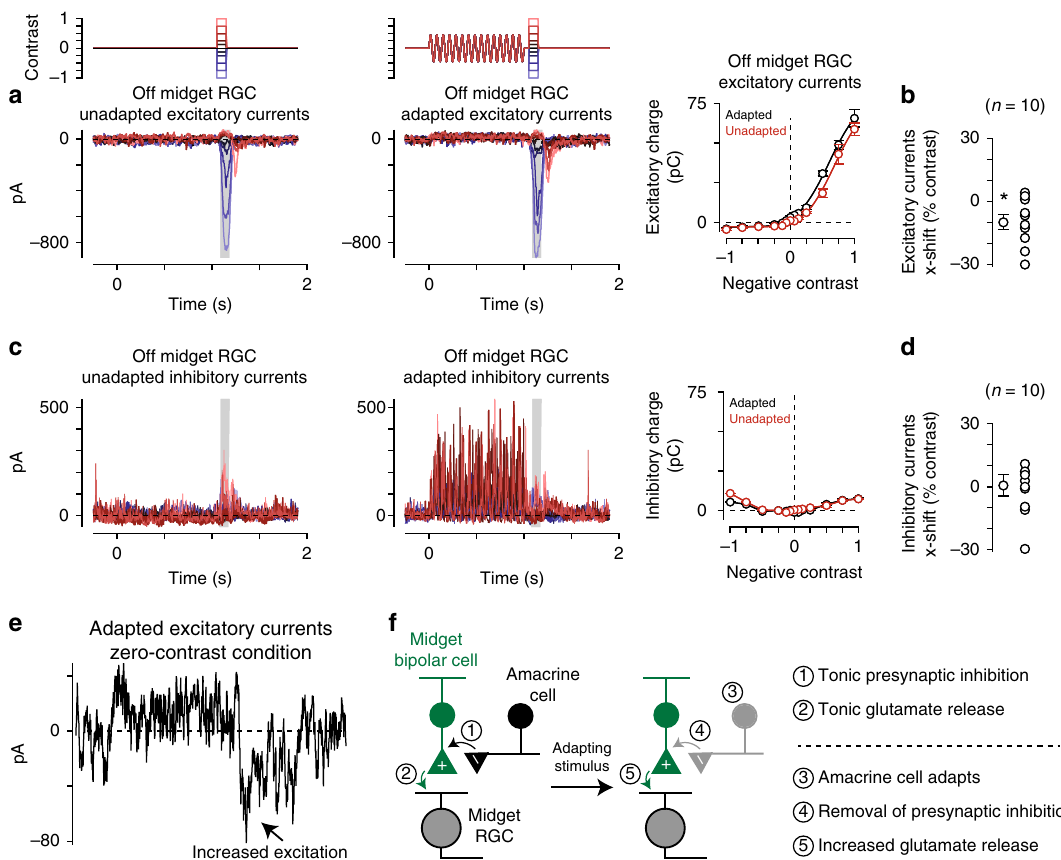
Fig. 7 Sensitization was present in excitatory synaptic input from midget bipolar cells. a Excitatory synaptic currents from a central Off midget ganglion cell to a series of spots (diameter, 40 – 80 μ m) centered over the receptive fi eld. Spots were either presented alone (left) or 50 ms following the offset of an adapting stimulus (right; diameter, 730 μ m). Shaded regions indicate sampling windows. Right: Average excitatory synaptic charge across the shaded regions. The wide- fi eld adaptation evoked a leftward shift in the contrast-response curve (black) relative to the unadapted control condition (red). b Population data from midget cells showing the x -axis shift for adapted relative to unadapted conditions in excitatory synaptic currents. The adapting stimulus evoked a signi fi cant leftward shift relative to the unadapted condition, indicating that contrast sensitization was present in the excitatory input from midget bipolar cells to midget ganglion cells ( n = 10 cells; p = 1.4 × 10 – 2 ). Mean values are shown in gray. Open circles are individual cells. c Inhibitory synaptic currents from the Off midget cell in ( a ). Inhibitory currents did not show a noticeable shift along the x -axis (right) and were small relative to excitatory currents recorded in the same cell (compare ( a ) with ( c )). d Horizontal shift values for inhibitory synaptic inputs as in ( b ). Inhibitory inputs did not show consistent leftward shifts, indicating that postsynaptic inhibition was unlikely to contribute to the contrast sensitization observed in the spike output of midget ganglion cells ( n = 10 cells; p = 0.15). Error bars indicate mean ± SEM. Statistical signi fi cance determined with Wilcoxon signed rank test. e Excitatory current recordings from the Off midget cell in ( a ) under the condition in which the stimulus intensity returned to the mean luminance after the offset of the adapting stimulus and an additional test fl ash was not presented (zero-contrast condition). A sustained increase in excitatory current